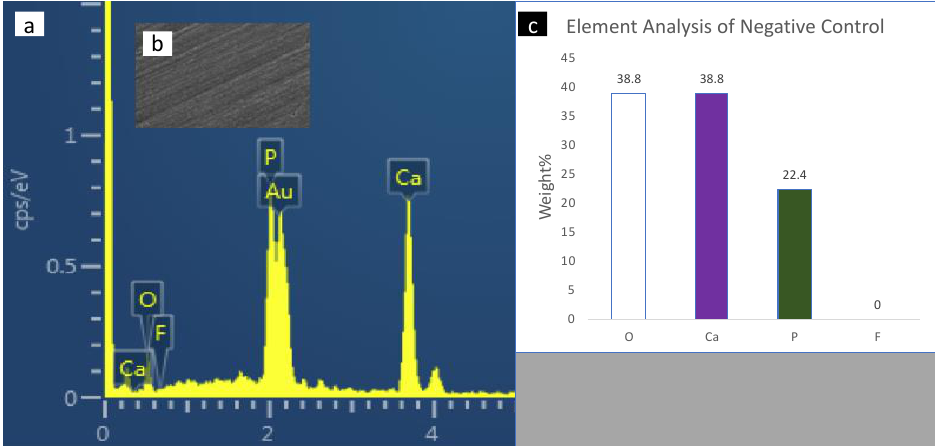
Figure 4. The SEM-EDX evaluation of the enamel samples (blank group): ( a ) the SEM-EDX spectrum shows the dominant elements; ( b ) SEM image of the area for which the EDX spectrum was acquired; ( c ) concentrations of elements in weight (weight percent) of the oxygen, calcium, phosphate and fluoride elements found in enamel surface under the sealants.